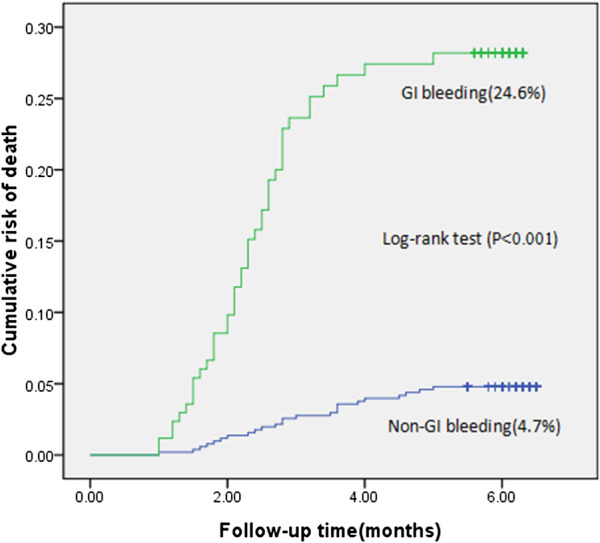
Cumulative risk of death in patients with gastrointestinal bleeding compared with patients without gastrointestinal bleeding (the logrank test, p < 0.001).